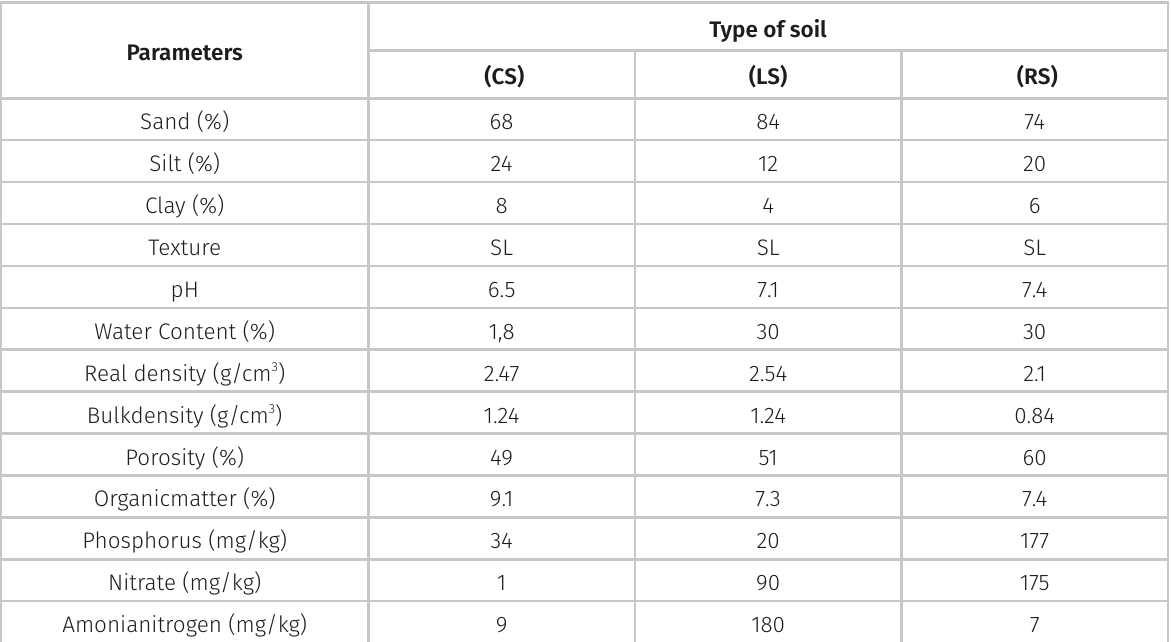
Table I. Physical and chemical properties of contaminated soil samples from Valle del Guamuez (Putumayo,